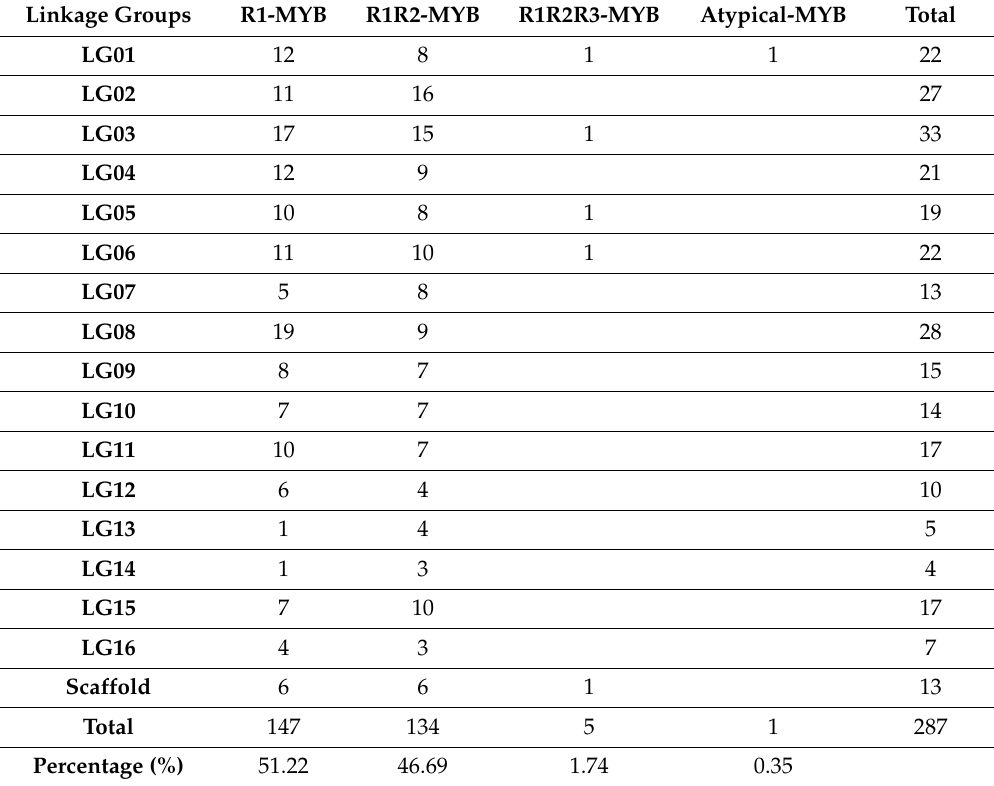
Table 1. Classification of the MYB gene family and distribution across the linkage groups (LG) of the sesame